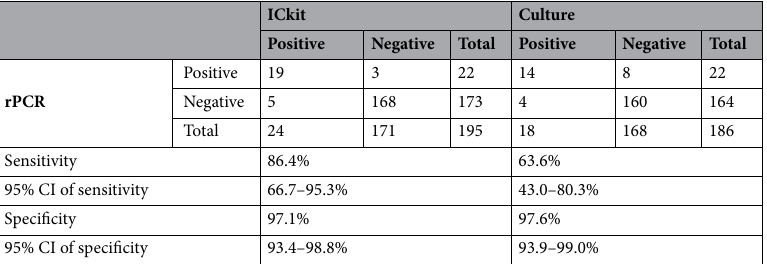
Table 4. Sensitivity, specificity, and concordance rate of the ICkit and culture compared with rPCR. A total of 195 cases were analyzed. Nine cases were tested by the ICkit and rPCR, but not tested by culture.